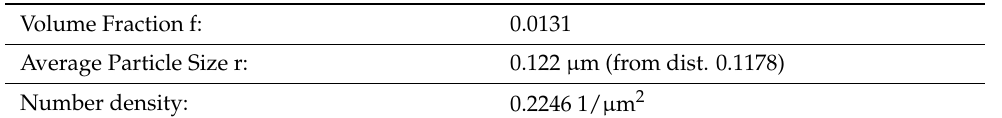
Table 2. Characteristics of the Er and Zn-containing precipitates in Mg-1%Er-1%Zn obtained by means of statistical analysis of BSE